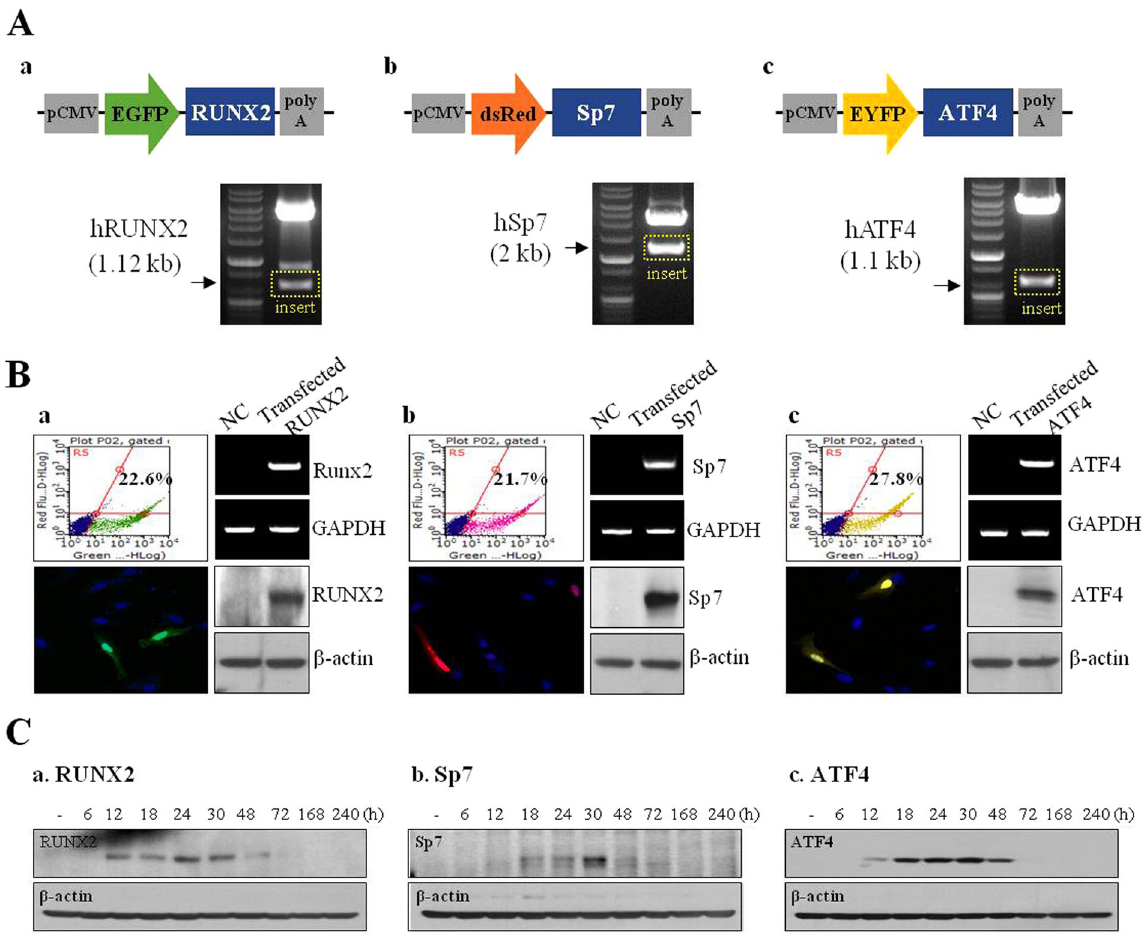
Figure 2. Fabrication and characterization of pDNAs harboring the RUNX2, SP7, and ATF4 genes. ( A ) Maps of plasmids harboring (a) EGFP-RUNX2, (b) dsRed-SP7, and (c) EYFP-ATF4. ( B ) Effects of exogenous gene expression on mRNA and protein levels of (a) RUNX2, (b) SP7, and (c) ATF4 in hMSCs detected by FACS, RT-PCR, confocal laser microscopy, and Western blot analyses. ( C ) Production of (a) RUNX2, (b) SP7, and (c) ATF4 proteins over time following transfection of the corresponding